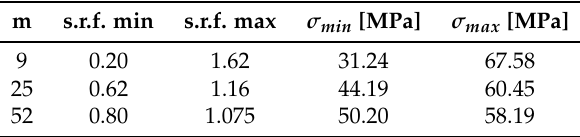
Table 3. Weibull parameters.